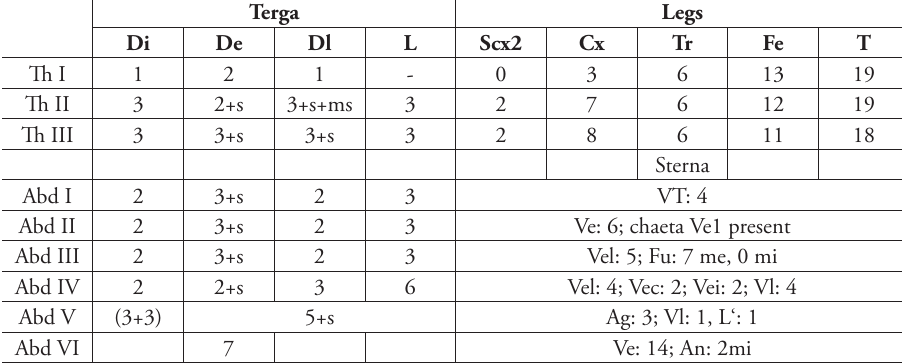
Table 3c. Chaetotaxy of Endonura turkmenica sp. n.: postcephalic chaetotaxy.